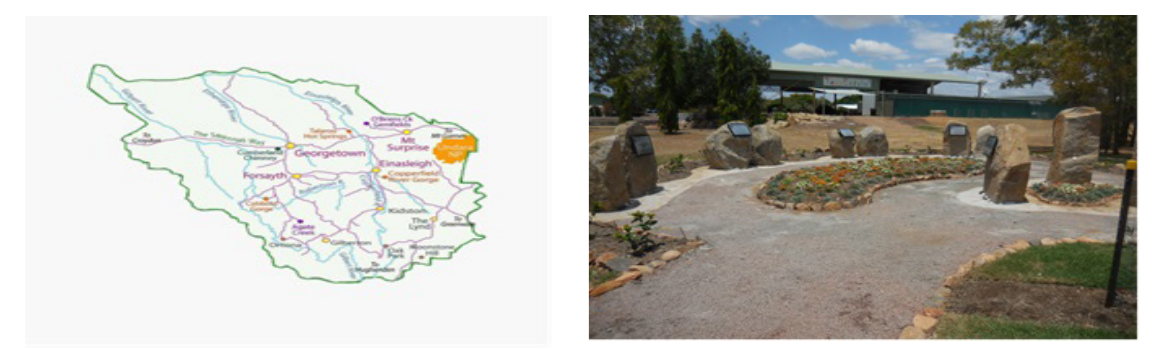
Figure 8. Etheridge Shire Townships Figure 9. TerrEstrial Museum and the Peace Monument,